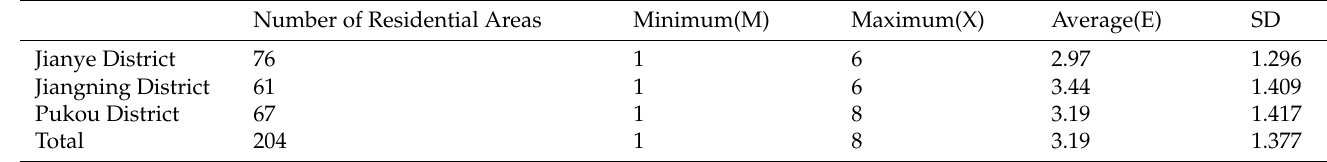
Table 3. Numbers of entrances and exits of 204 residential areas in Jiangning, Jianye, and Pukou